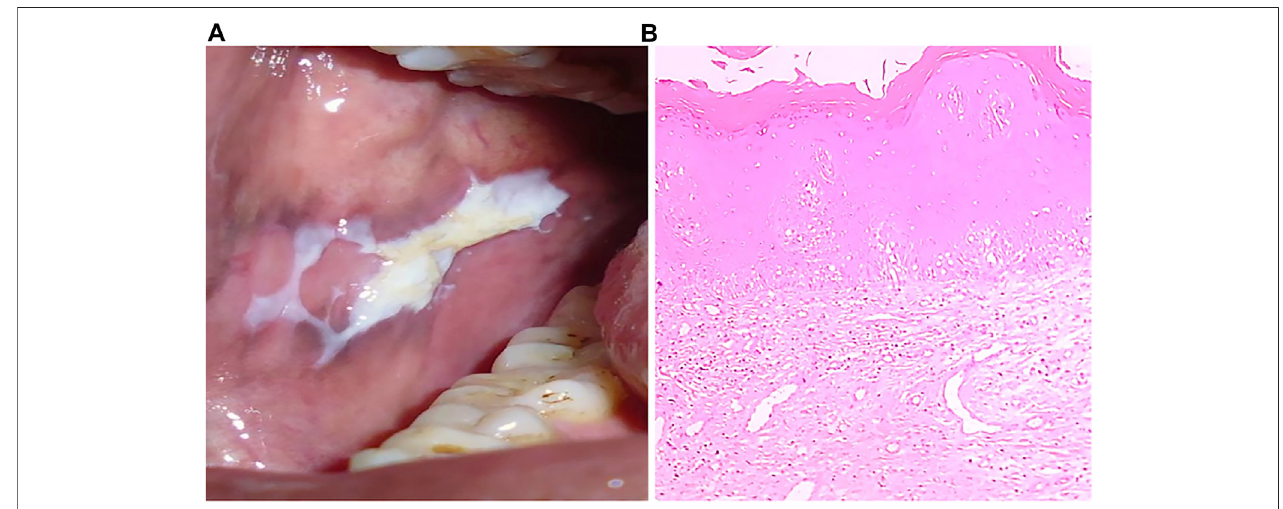
FIGURE3|(A) Clinicalpresentationofleukoplakia,atypicalappearanceofwhitepatch. (B) H&Estainedsection(4x)showinghyperkeratinizedstrati fi edsquamous